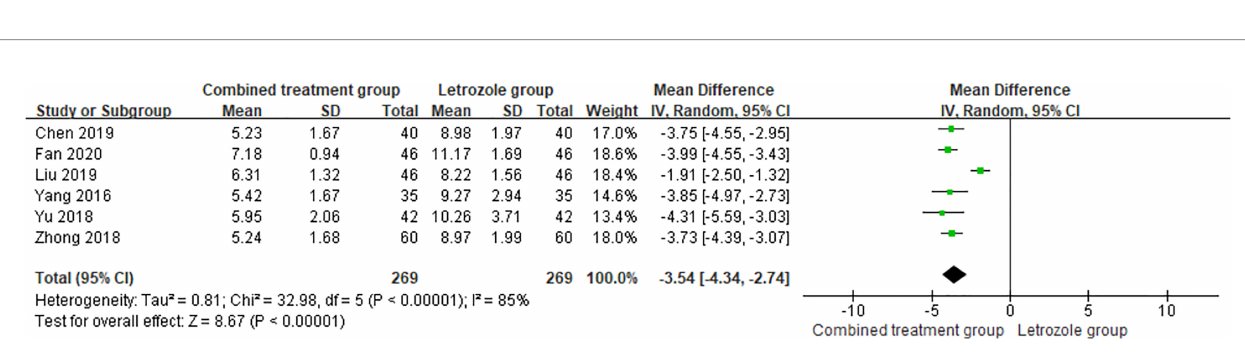
FIGURE 6 | Meta-analysis of the effect of Kuntai capsule combined with letrozole on luteinizing hormone (LH) in polycystic ovary syndrome (PCOS).